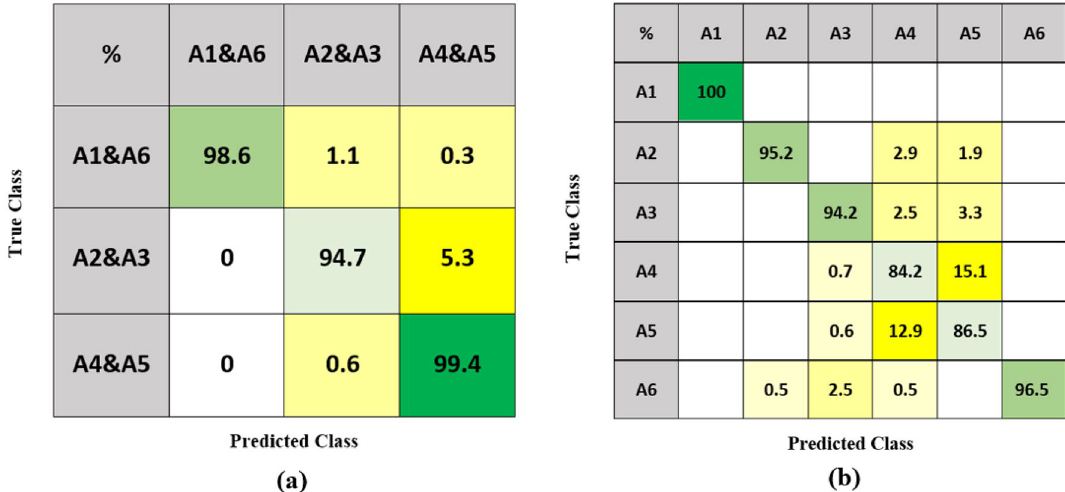
Figure 8. Confusion matrix of 1st stage classification ( a ) and result of the 2nd hierarchical classification ( b